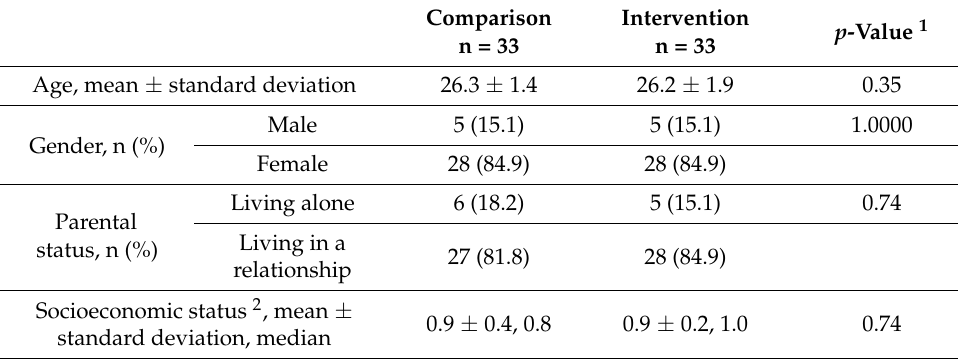
Table 2. No differences in age, gender, parental status, or socioeconomic status were found between the facilitator and the comparison groups. Table 2. Participants’ baseline demographic